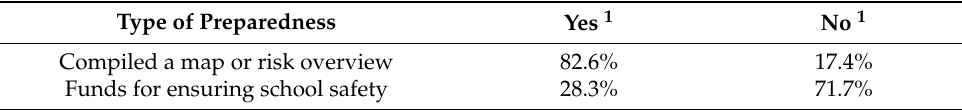
Table 2. Schools safety